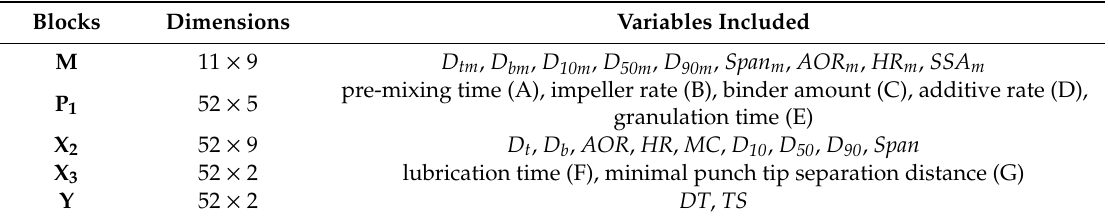
Table 3. Data blocks organization.